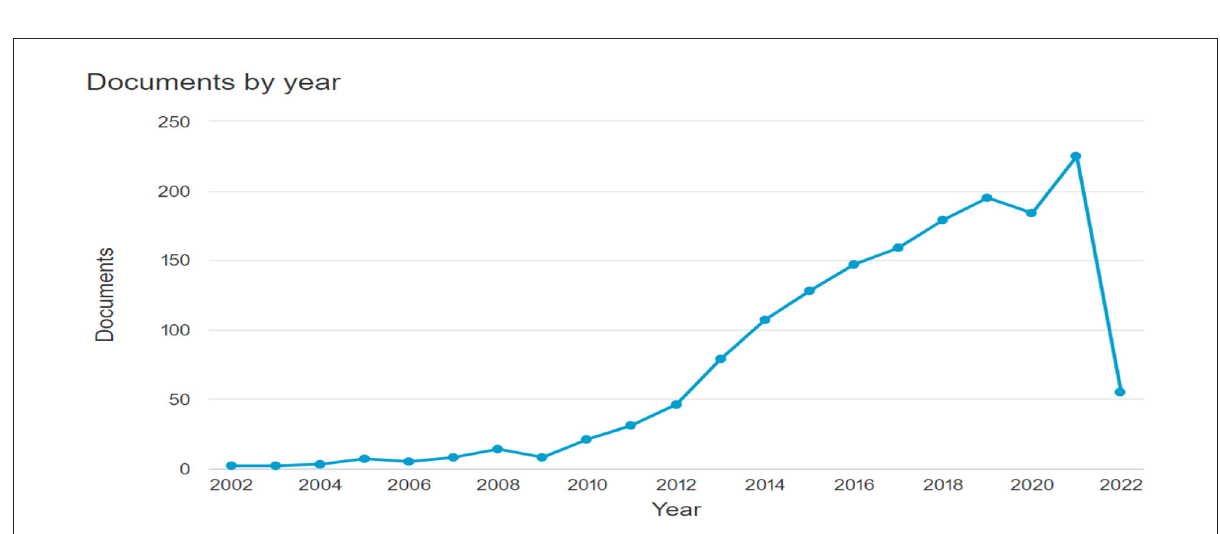
FIGURE2 Annual scientific production. Source: Own elaboration using Bibliometrix.